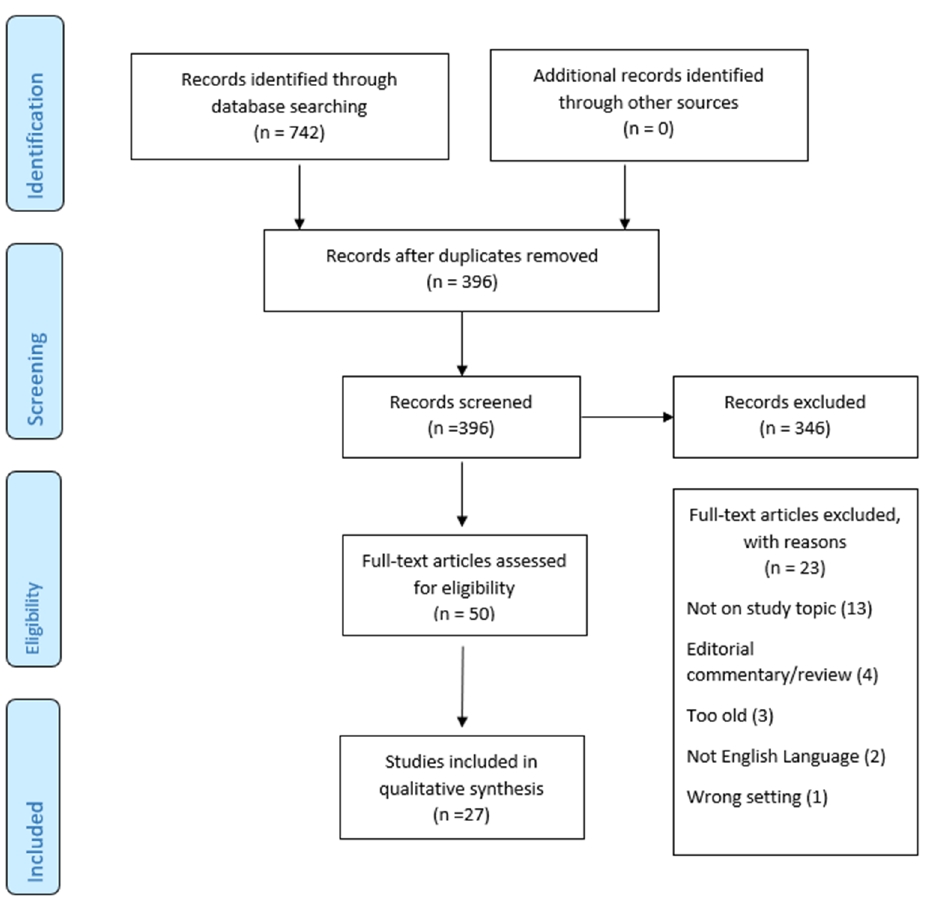
Figure 1. Article Selection Flow Chart.